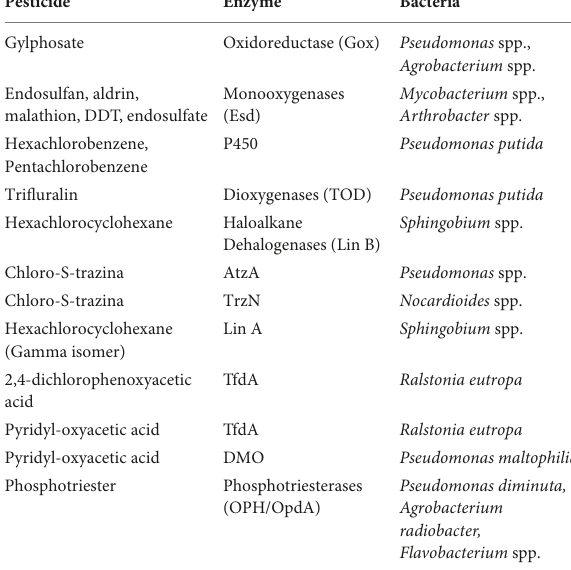
TABLE 7 Bacterial enzymes, responsible for the degradation of pesticides (Ortiz-Hernández et al., 2013). Pesticide Enzyme Bacteria Gylphosate Oxidoreductase (Gox) Pseudomonas spp., Agrobacterium spp. Endosulfan, aldrin, Monooxygenases malathion, DDT, endosulfate